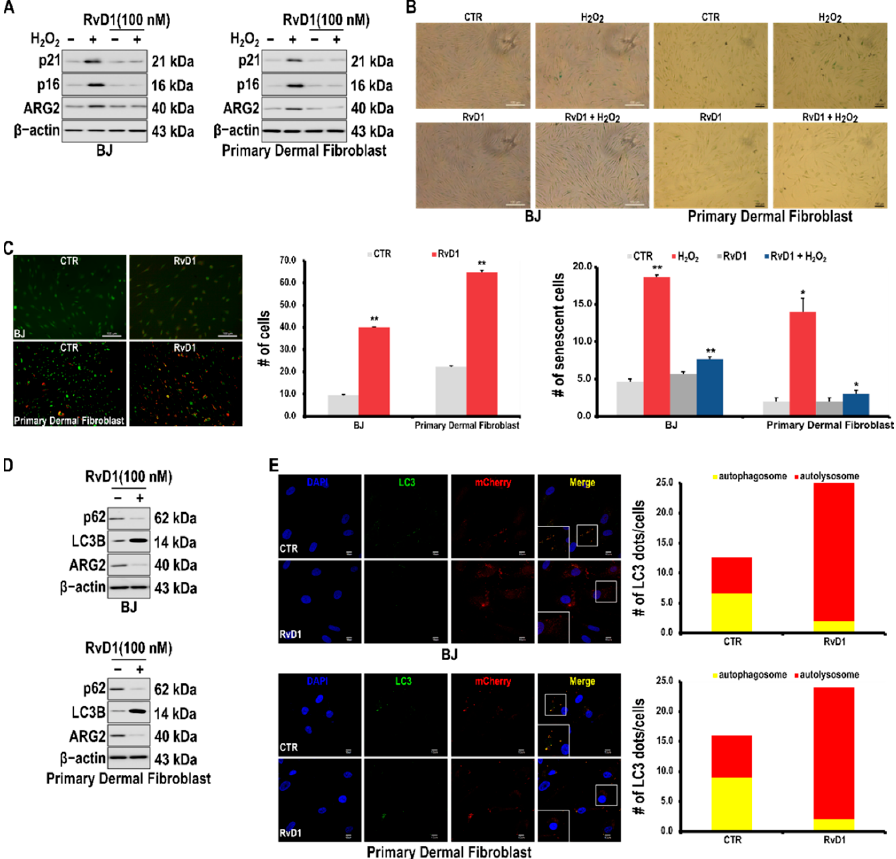
Figure 5. Effects of RvD1 on H 2 O 2 –induced cell senescence in skin fibroblasts. Cells were pretreated with RvD1 for 2 h, and subsequently treated with H 2 O 2 (200 µ M) for 24 h. ( A ) Effects of RvD1 on the expression of cellular senescence markers p16